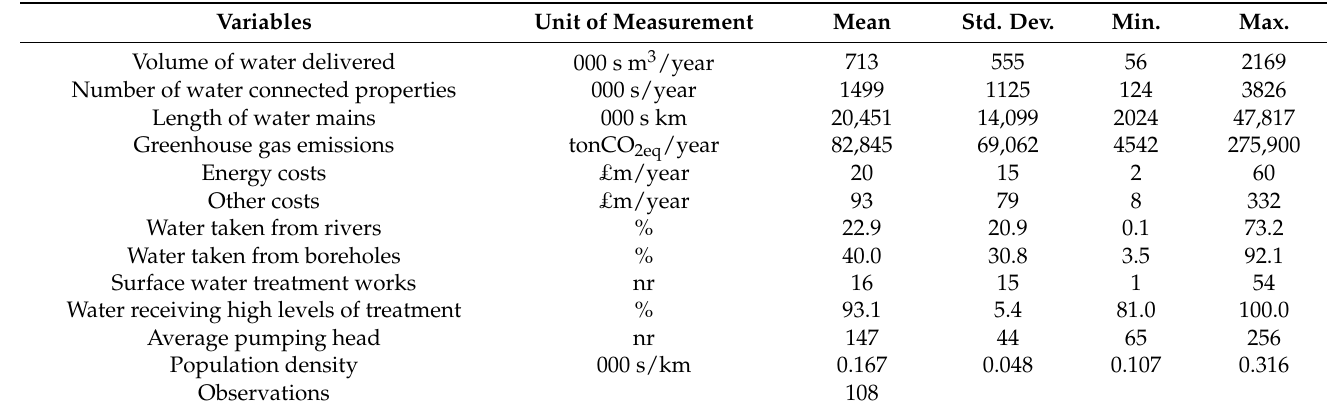
Table 1. Descriptive statistics of the variables used.